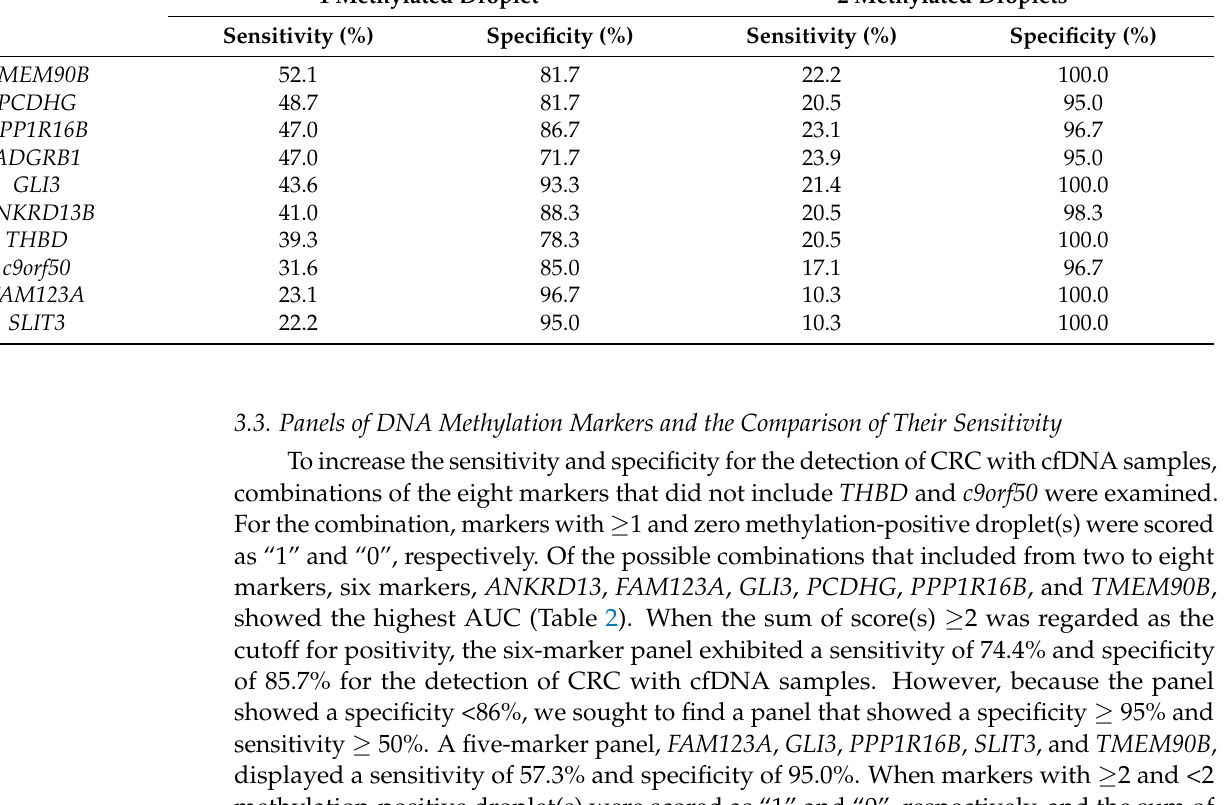
Table 1. Sensitivity and specificity of each marker according to the different criteria of positivity. Cut-off for Positivity Set at 1 Methylated Droplet